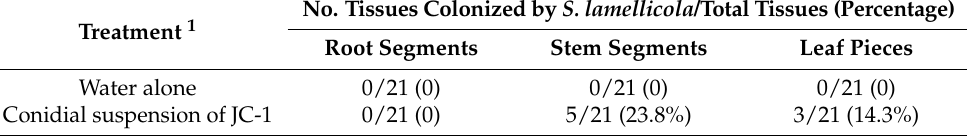
Table 3. Number and percentages of tissues of oilseed rape (roots, stems and leaves) colonized by S. lamellicola JC-1.